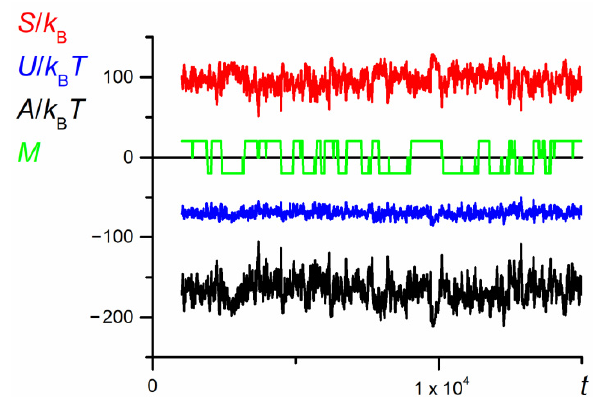
Figure 3. The dependence of the entropy, internal energy, and Helmholtz free energy of the chain on the number of MC steps ( N = 100, ε PP / k B T = − 1 and 0 for P1 and P2, respectively, D = 3 b ). The time changes in the mutual orientation parameter, M, along the x direction are marked in green. The chart is based on the data recorded in periods of t E = 10 3 elementary steps.